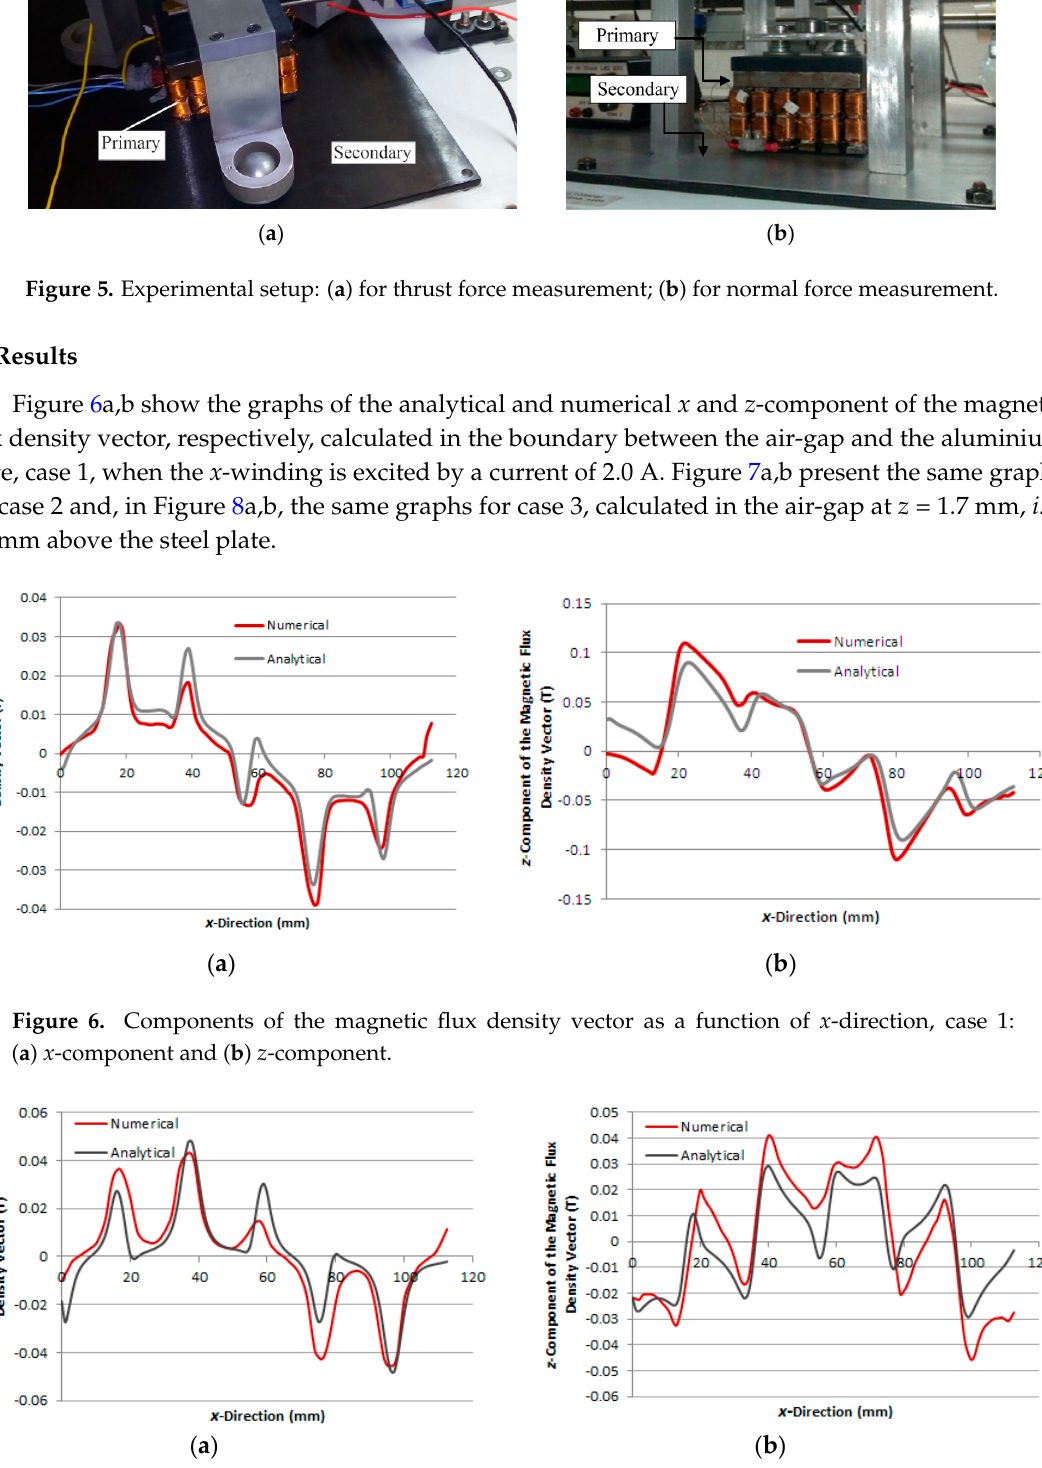
( a ) ( b ) Figure 8. Components of the magnetic flux density vector as a function of x -direction, case 3: ( a ) x -component and ( b ) z -component. Figure 9a,b present the graphs of thrust and normal measured forces produced by the induction planar actuator when only x -winding is fed, case 1. For the sake of comparison, numerical and analytical results are presented as well. Figure 10a,b present the graphs of thrust and normal results of forces produced by the induction planar actuator when both x and y -windings are fed, case 1. As seen in Figure 10a, the x and y -direction forces produced are equal, as expected, since there is symmetry involved, and those forces are slightly lower than the corresponding forces when only one winding is excited − 1.50% lower on average. Additionally, a higher net thrust force is produced by the combination of the x and y -direction forces, according to Figure 10b. ( a ) ( b ) Figure 9. Case 1: ( a ) thrust force and ( b ) normal force produced by the induction planar actuator with only the x -winding excited.